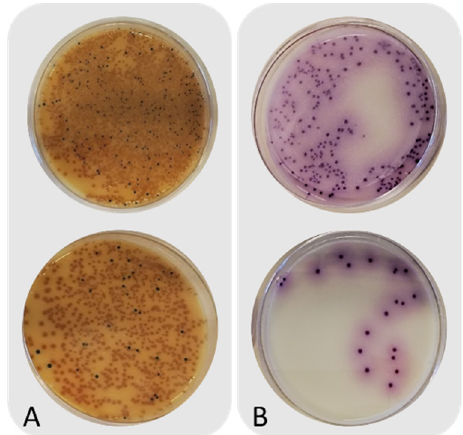
Figure A1. Determination of Salmonella spp. in inoculated frass using RAPID’ Salmonella agar plates ( A ) without kanamycin, overgrown by background microbiota (blue and brown colonies represent other Enterobacteriaceae and Proteus spp. respectively), ( B ) supplemented with kanamycin and with countable kanamycin-resistant Salmonella colonies (purple colonies represent Salmonella